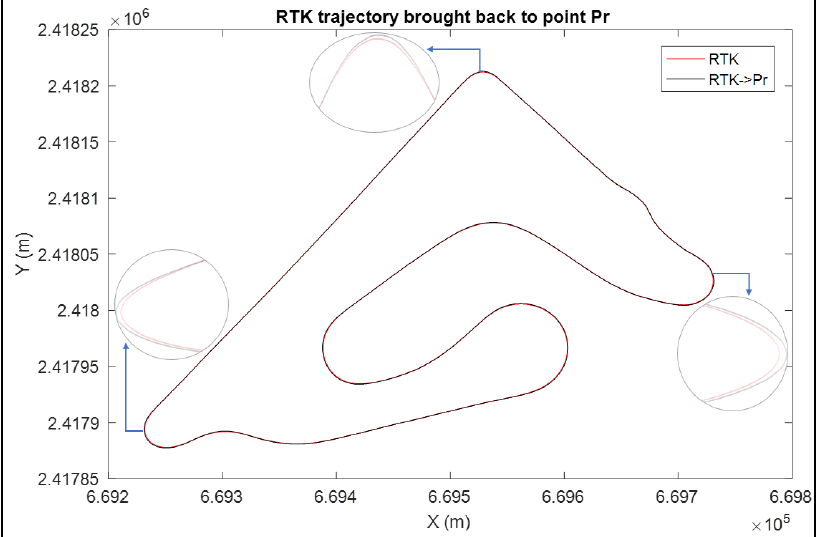
Figure 5. The reference trajectory brought back to the rear contact point.